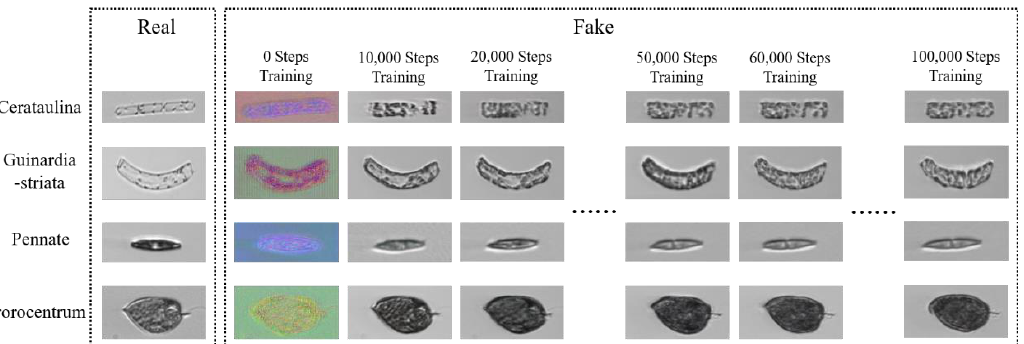
Figure 7. Illustration of fake data production with different training steps. Table 2. Components of the dataset with data augmentation for one rare taxa.